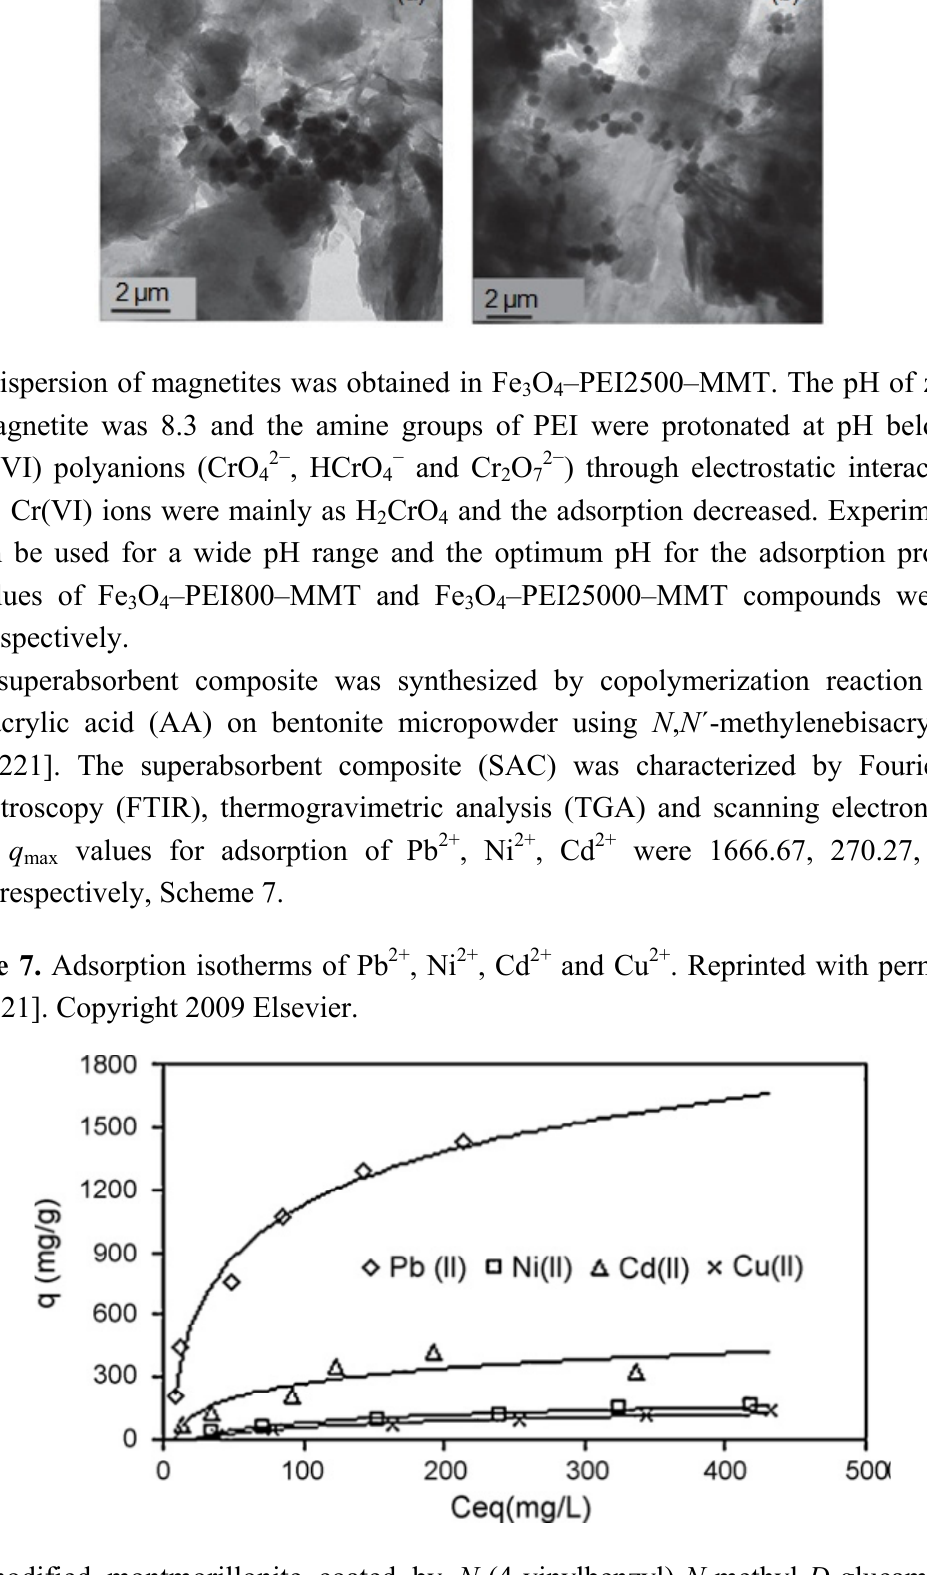
O –PEI2500–MMT 3 4